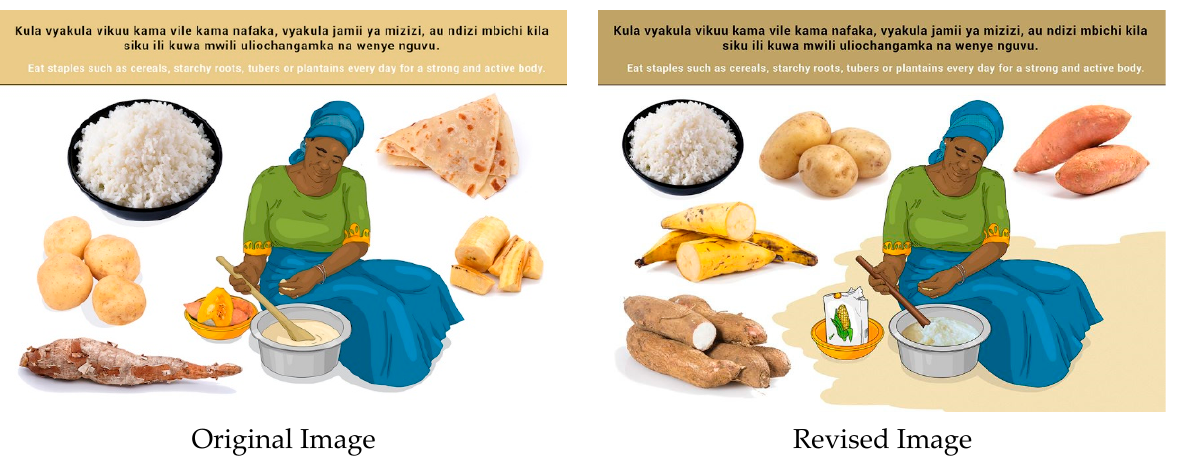
Figure 8. Eat staples such as cereals, starchy roots, tubers or plantains every day for a strong and active body. active body.